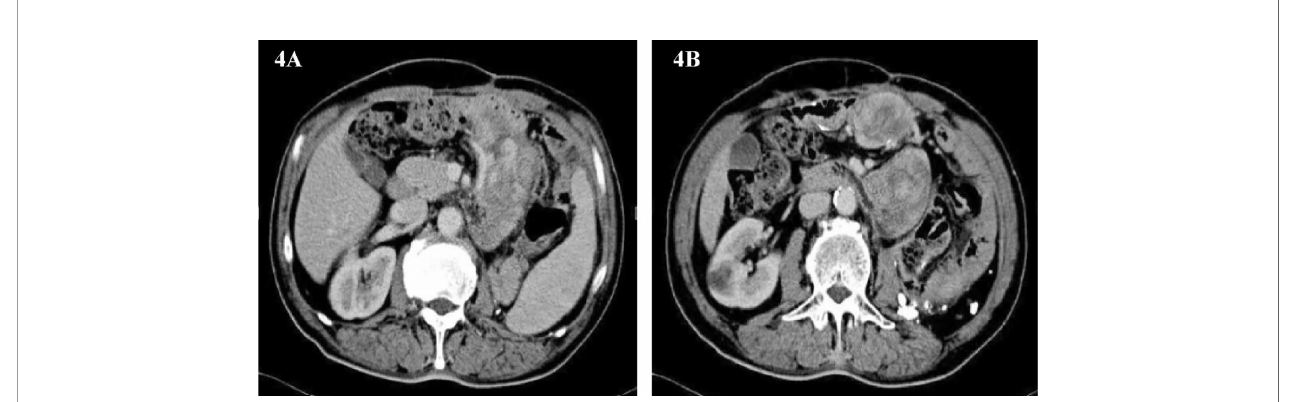
FIGURE 4 | (A, B) Abdominal image before the